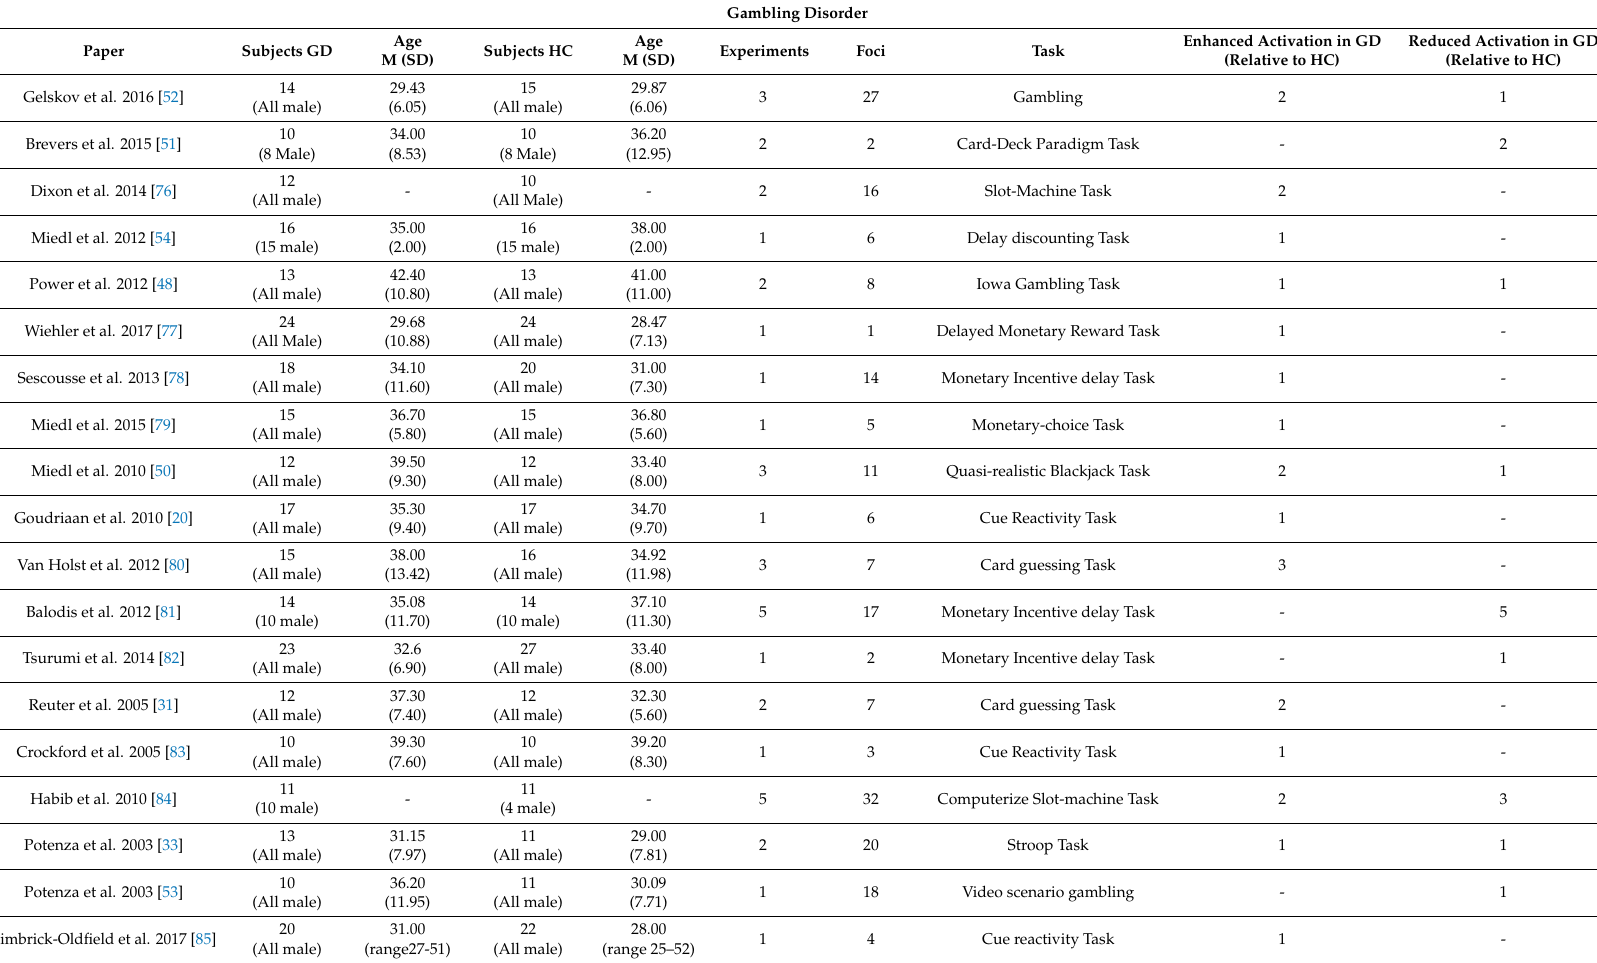
Table 1. Complete list of papers included in meta-analysis for Gambling Disorder. For each paper, details about the number of participants, the experimental paradigms, and the included contrasts in the studies are provided. GD = Gambling Disorder; HC = healthy